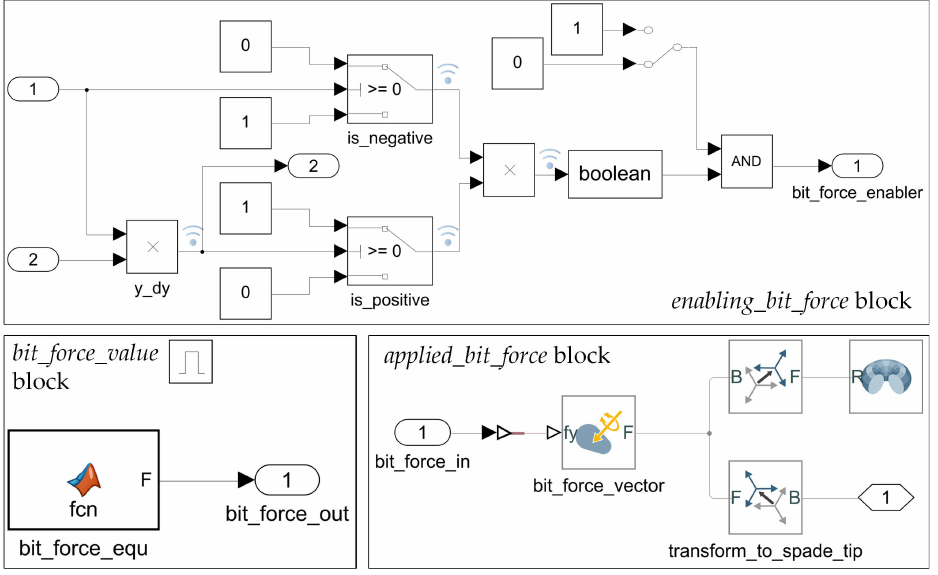
Figure 9. Blocks for calculating, enabling, and applying the bit force load.